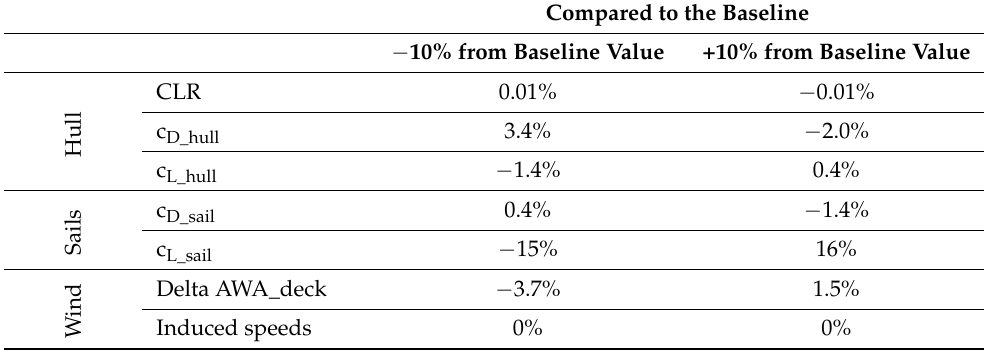
Table 3. Results of the sensitivity study for the ship with one Flettner